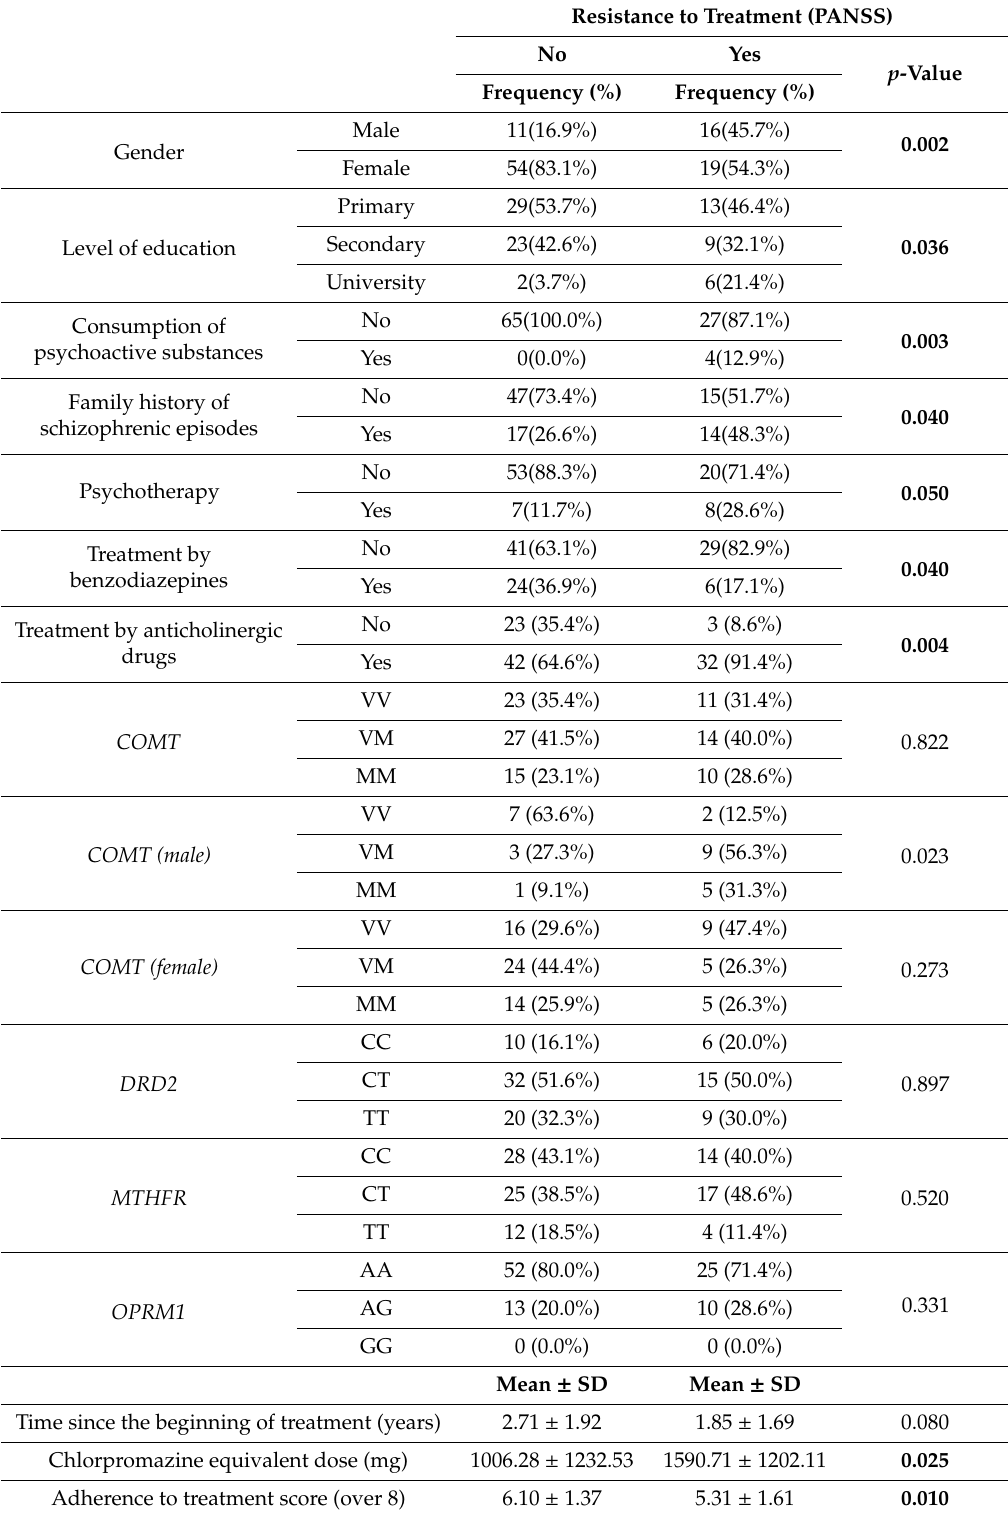
Table 4. Bivariate analysis taking the resistance to treatment, evaluated by the PANSS scale, as the dependent